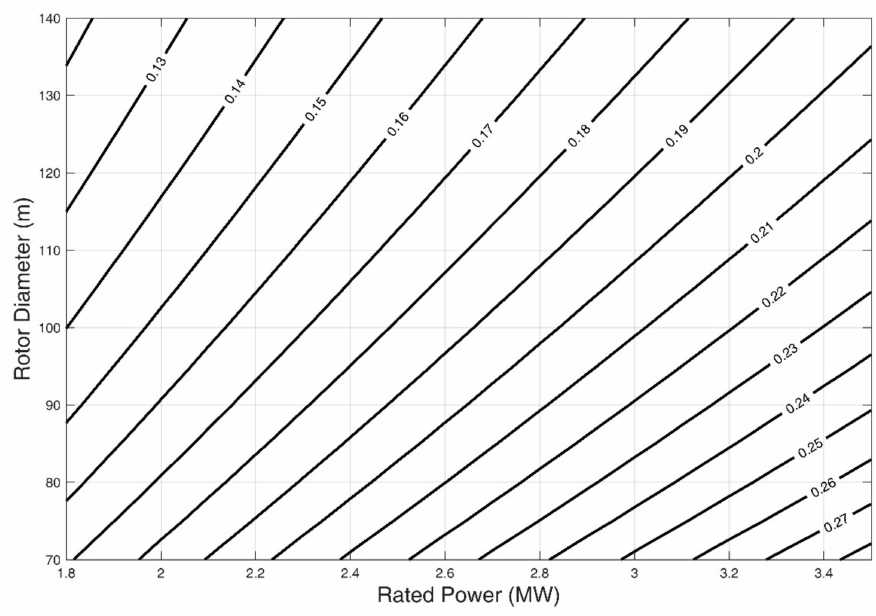
Figure 16. NCOE dependence on P R and D